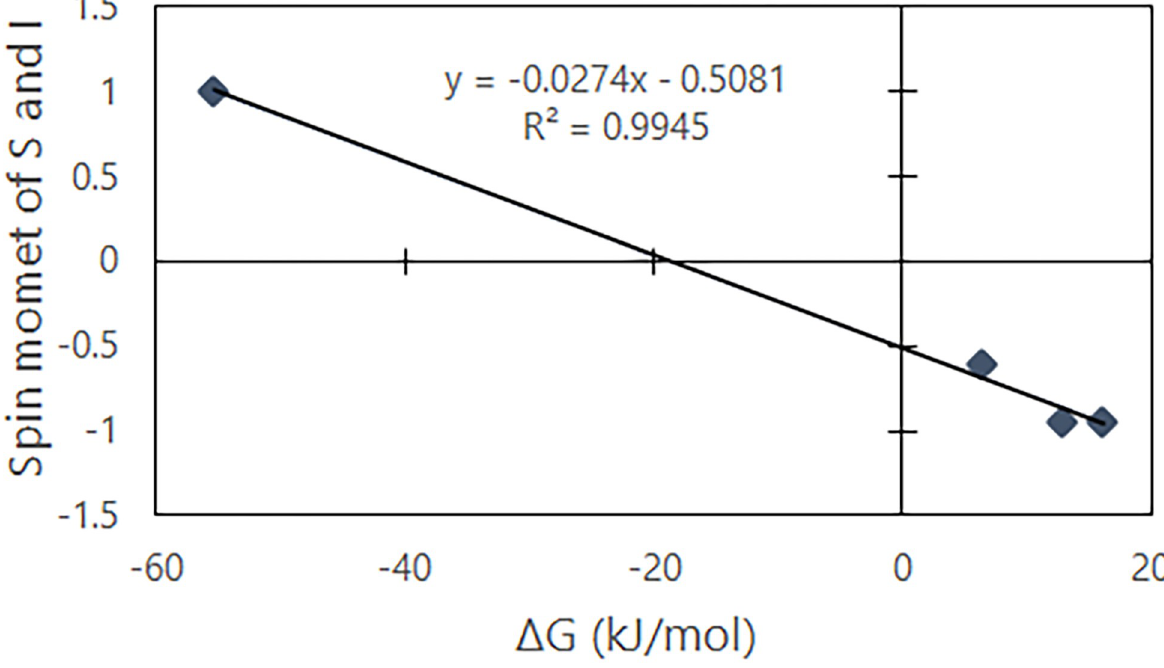
Fig 3. Relationship between the magnetic moments of gas molecules and gibs